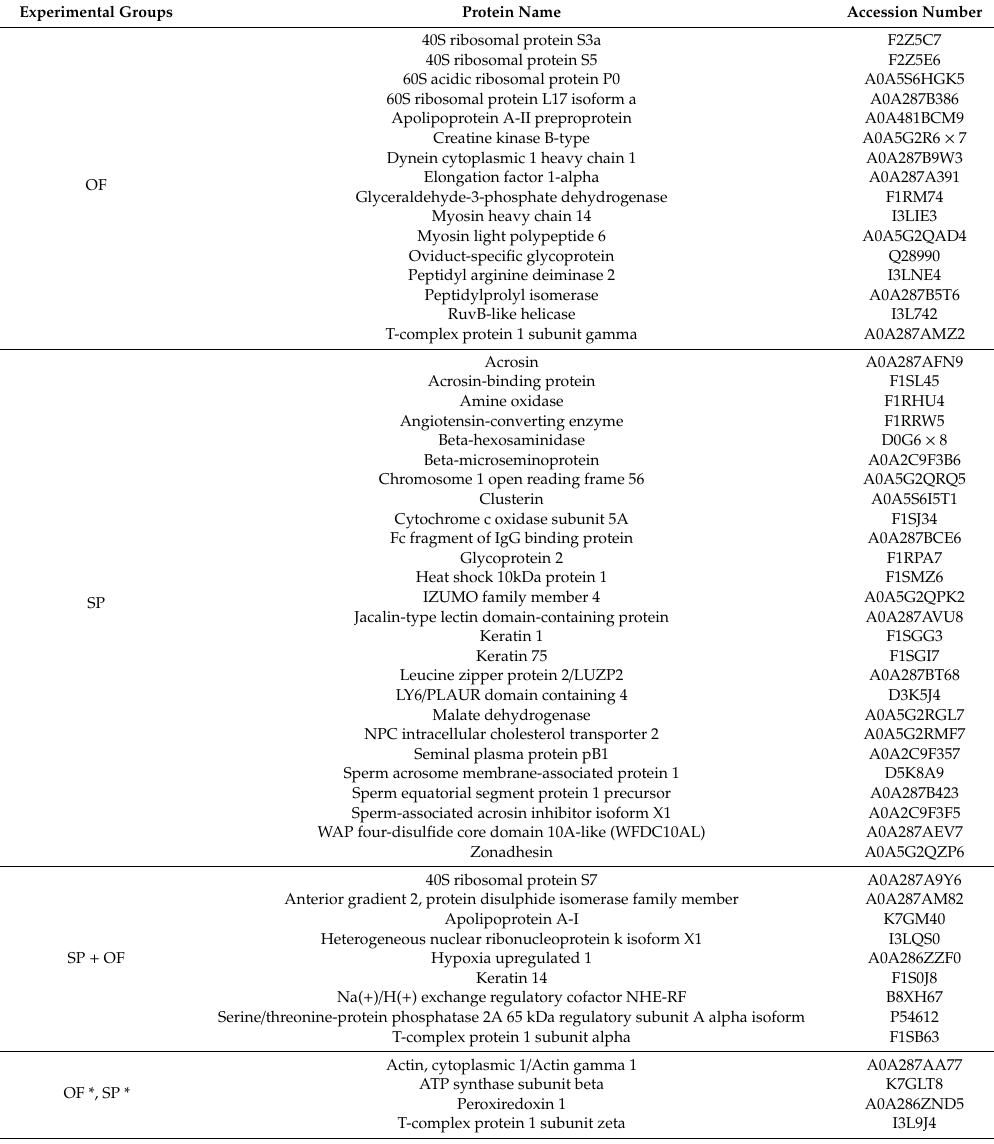
Table 2. List of boar spermatozoa proteins identified after incubation with oviductal fluid (OF group), with seminal plasma (SP group), and with oviductal fluid and seminal plasma (SP + OF